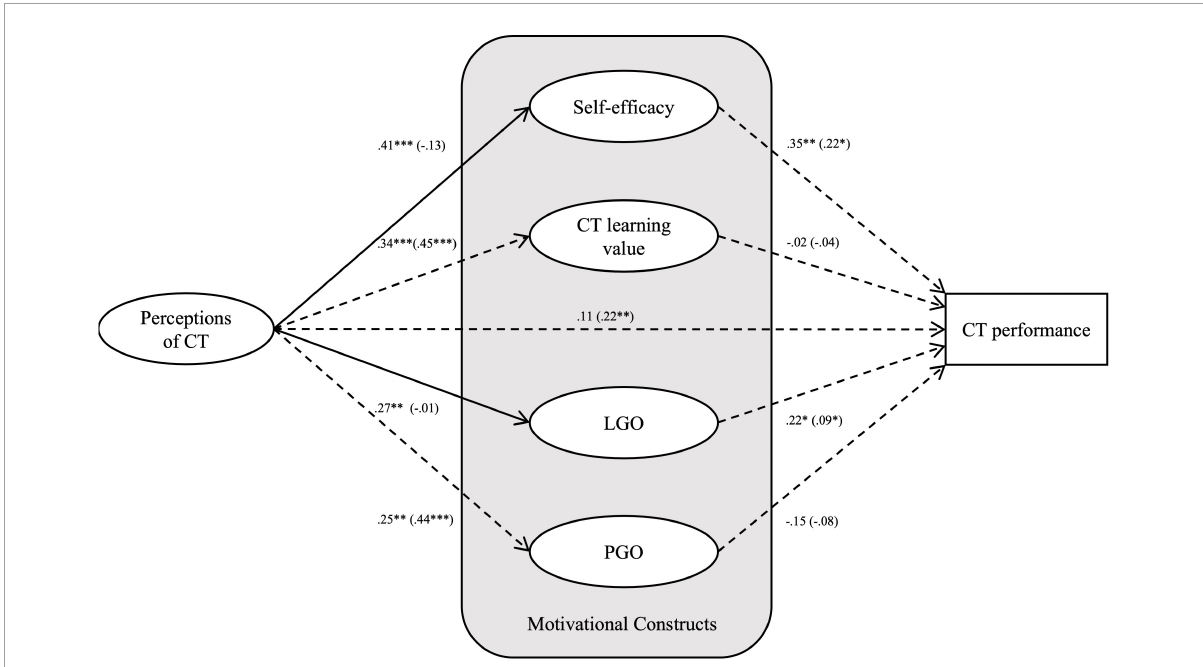
FIGURE4 Results of the partially constrained models. ∗ p < 0.05, ∗∗ p < 0.01, ∗∗∗ p < 0.001; β for the female group is in parentheses; solid lines indicate that the structural coefficients differ significantly across gender